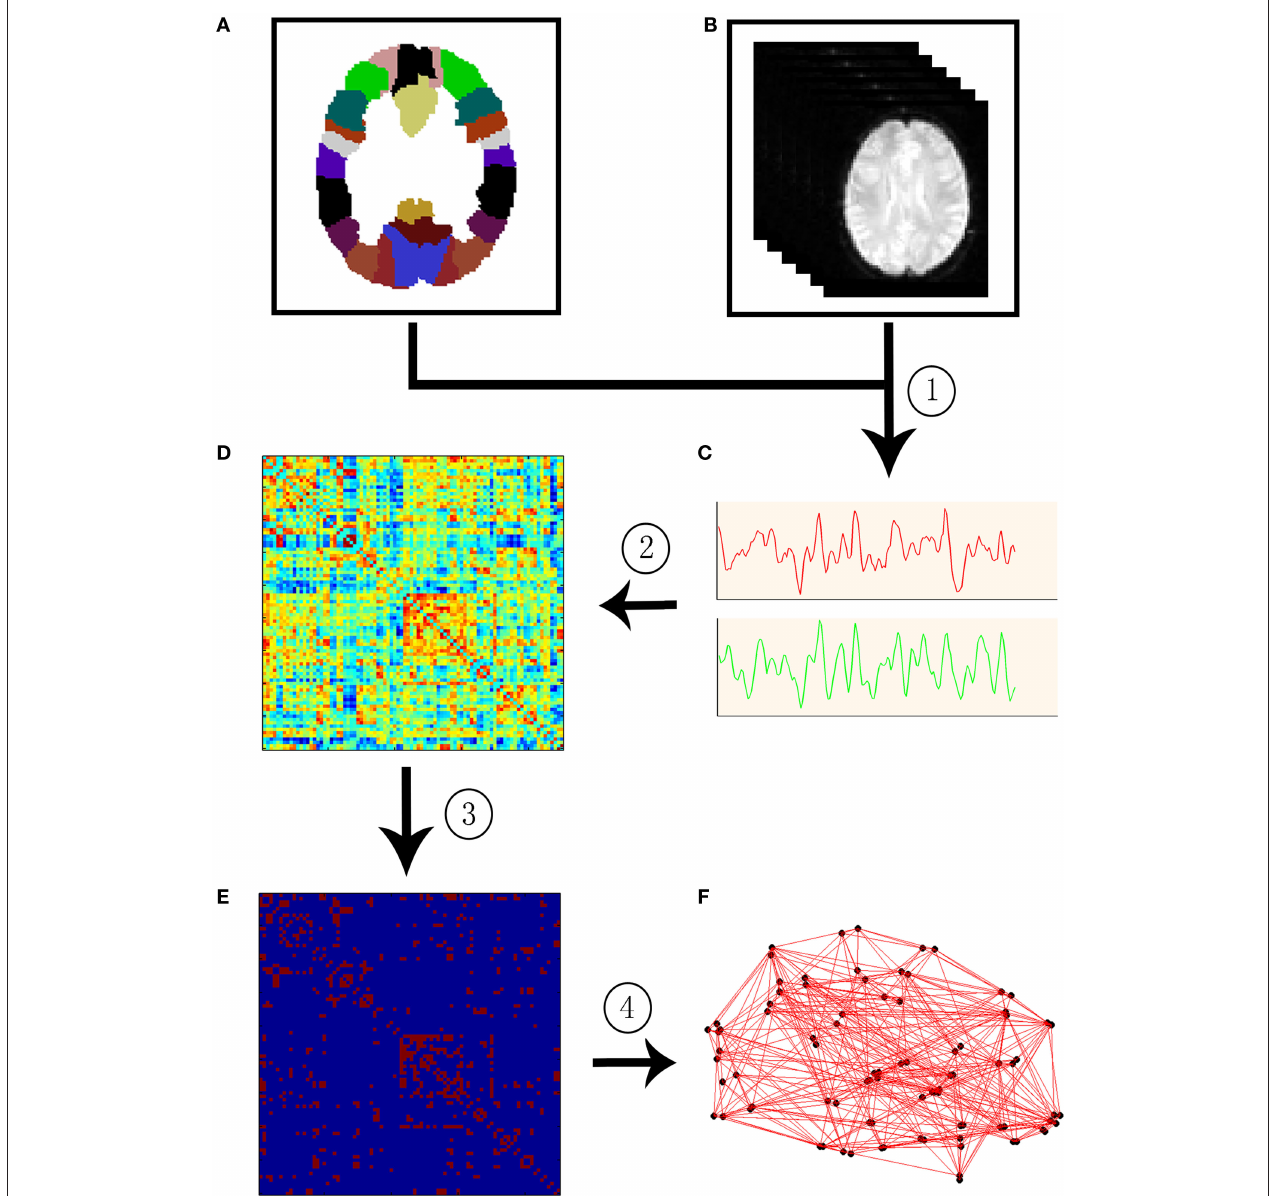
(2) Calculation of a functional connectivity (i.e., network edge) correlation matrix (D) between any pairs of nodes; (3) Thresholding the correlation matrix into a binary connectivity matrix (i.e., association matrix, e ); (4) Visualization of the association matrix as a graph (F)